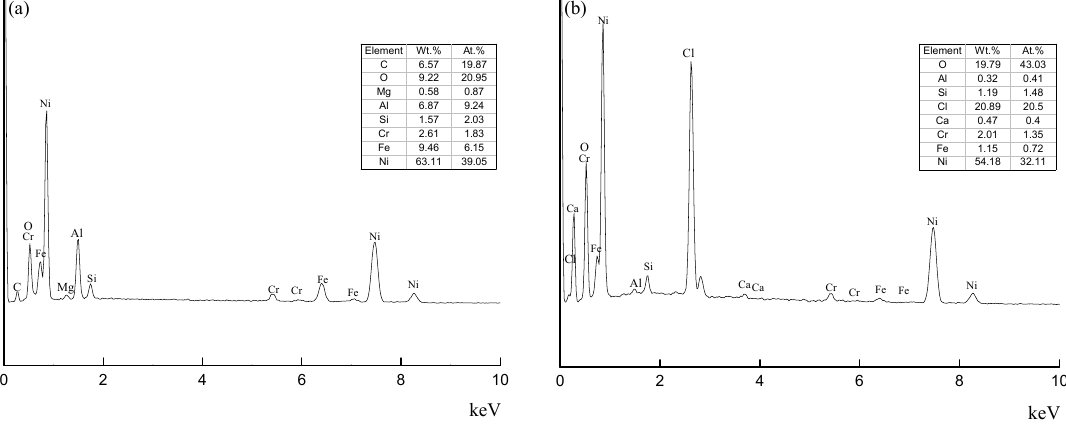
Figure 5. SEM images of the impurities: ( a ) bright impurity; ( b ) black impurity.